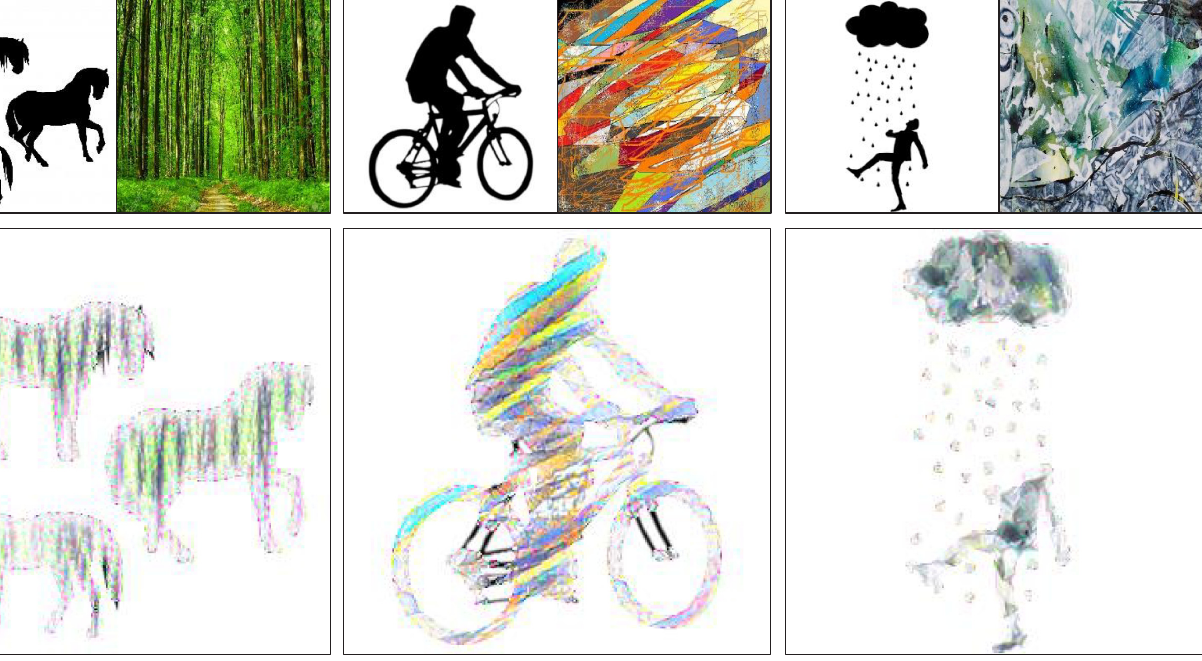
Fig 14. Photos and images without plain background as style